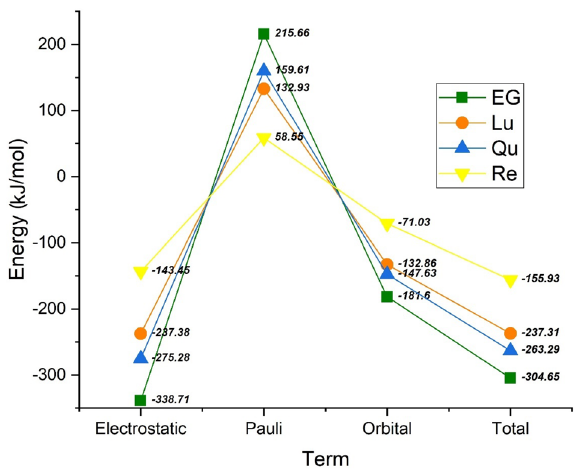
Figure 7. Energy decomposition of the interaction energy of the complexes into Pauli repulsion (E Pauli ), electrostatic (E elst ), and orbital interaction ( E orbit